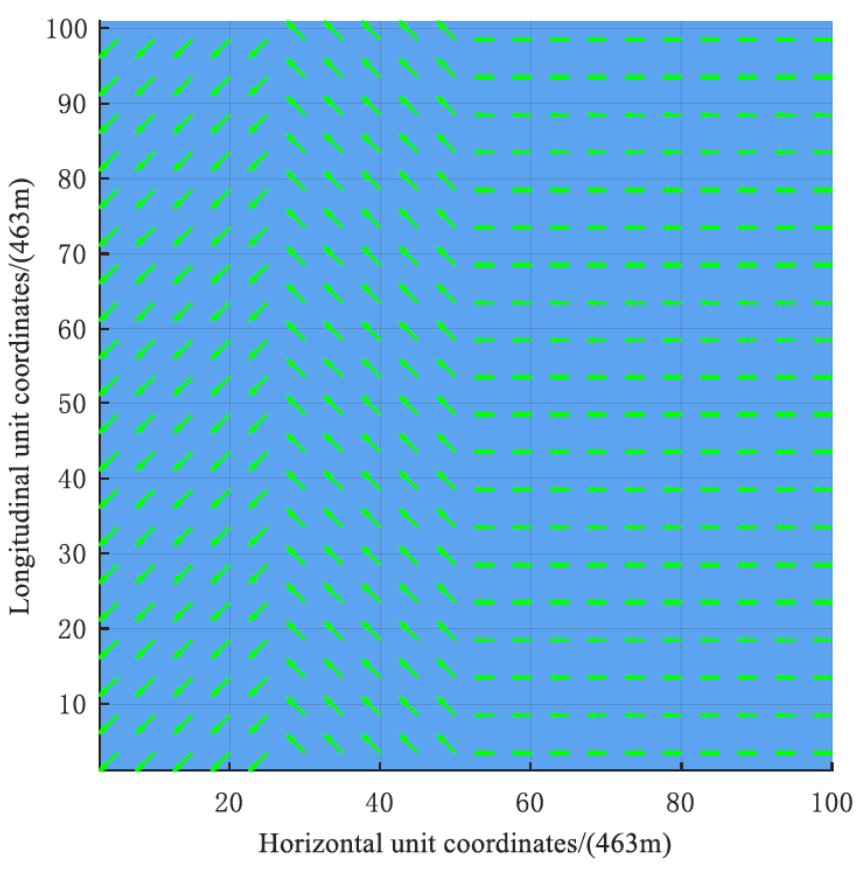
 . Figure 9. Artificial wind field at the time τ 1 . Figure 9. Artificial wind field at the time 1 The starting point position of the NSV is (1, 50), and the target point position is (100, 50). To test the effectiveness of the DW–Dijkstra algorithm, the energy consumption of the planned route is compared with the traditional A* algorithm and the Wind_A* algorithm. The results are shown as follows: Figure 11 shows the path diagrams of different algorithms, and Table 2 is the simulation energy consumption data comparison of different